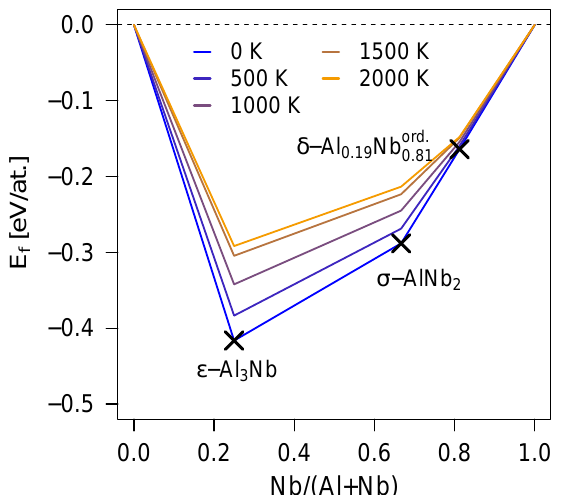
Figure 6. Energetics of the stable Al–Nb intermetallics—forming the convex hull—as a function of temperature.